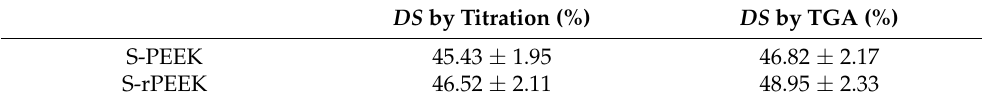
Table 1. Values of the degree of sulfonation from titration and the TGA method.